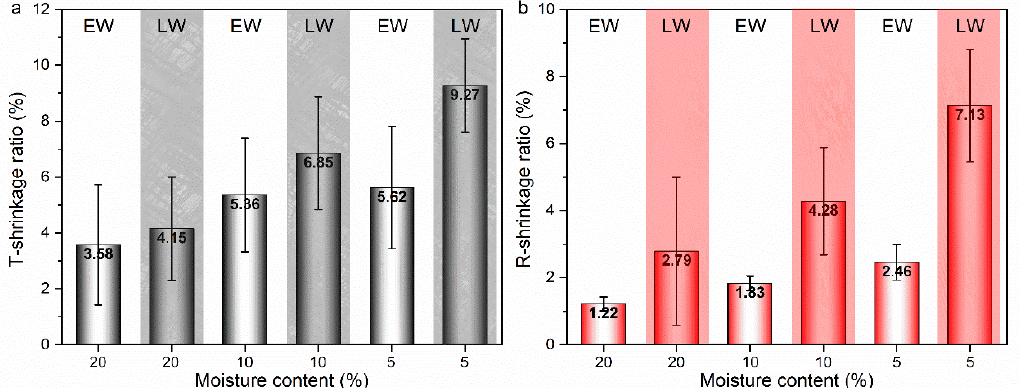
Figure 6. The shrinkage ratio of tracheid in early- and latewood in tangential ( a ) and radial ( b ) directions. White background for earlywood, red and black background for latewood.